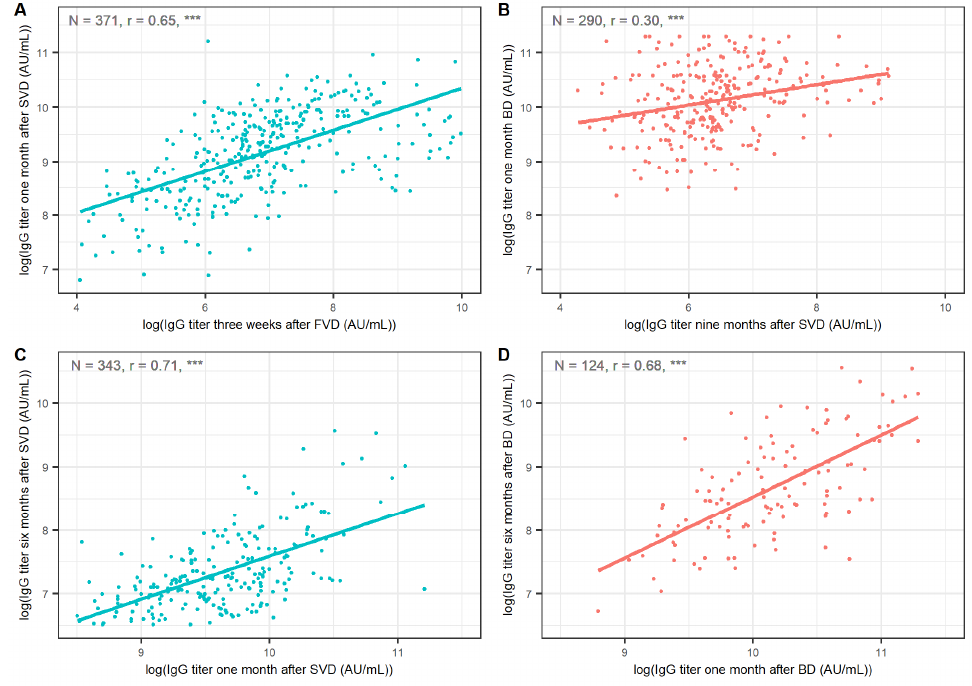
Figure 3. Correlations of antibody titers ( A ) one month after SVD and three weeks after FVD, ( B ) one month after BD and nine months after SVD, ( C ) six months after SVD and one month after SVD, ( D ) six months after BD and one month after BD. Points corresponding to IgG titers after primovaccination are coloured blue; points corresponding to IgG titers after the BD are coloured red. Titers were logarithmically transformed before plotting to ensure better visualisation. Sera after contracting COVID-19 were not included. FVD = first vaccine dose, SVD = second vaccine dose, BD = booster dose, r = Spearman’s correlation coefficient. *** p < 0.001 (correlation